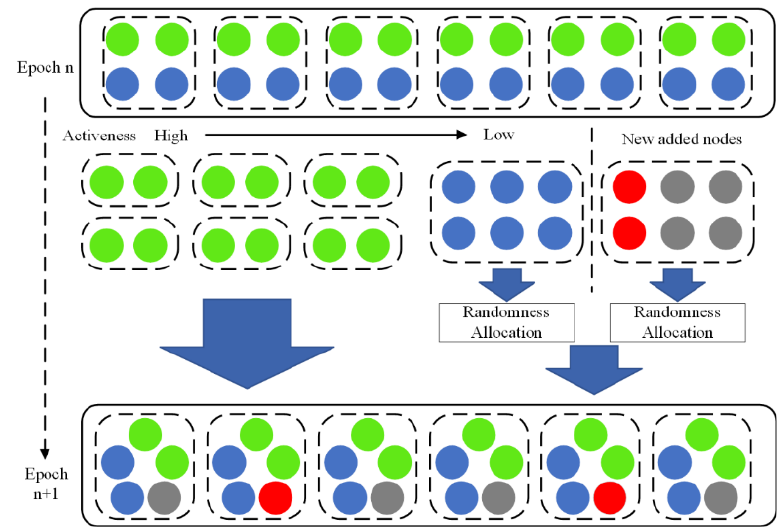
Figure 8. Shard reconfiguration process.